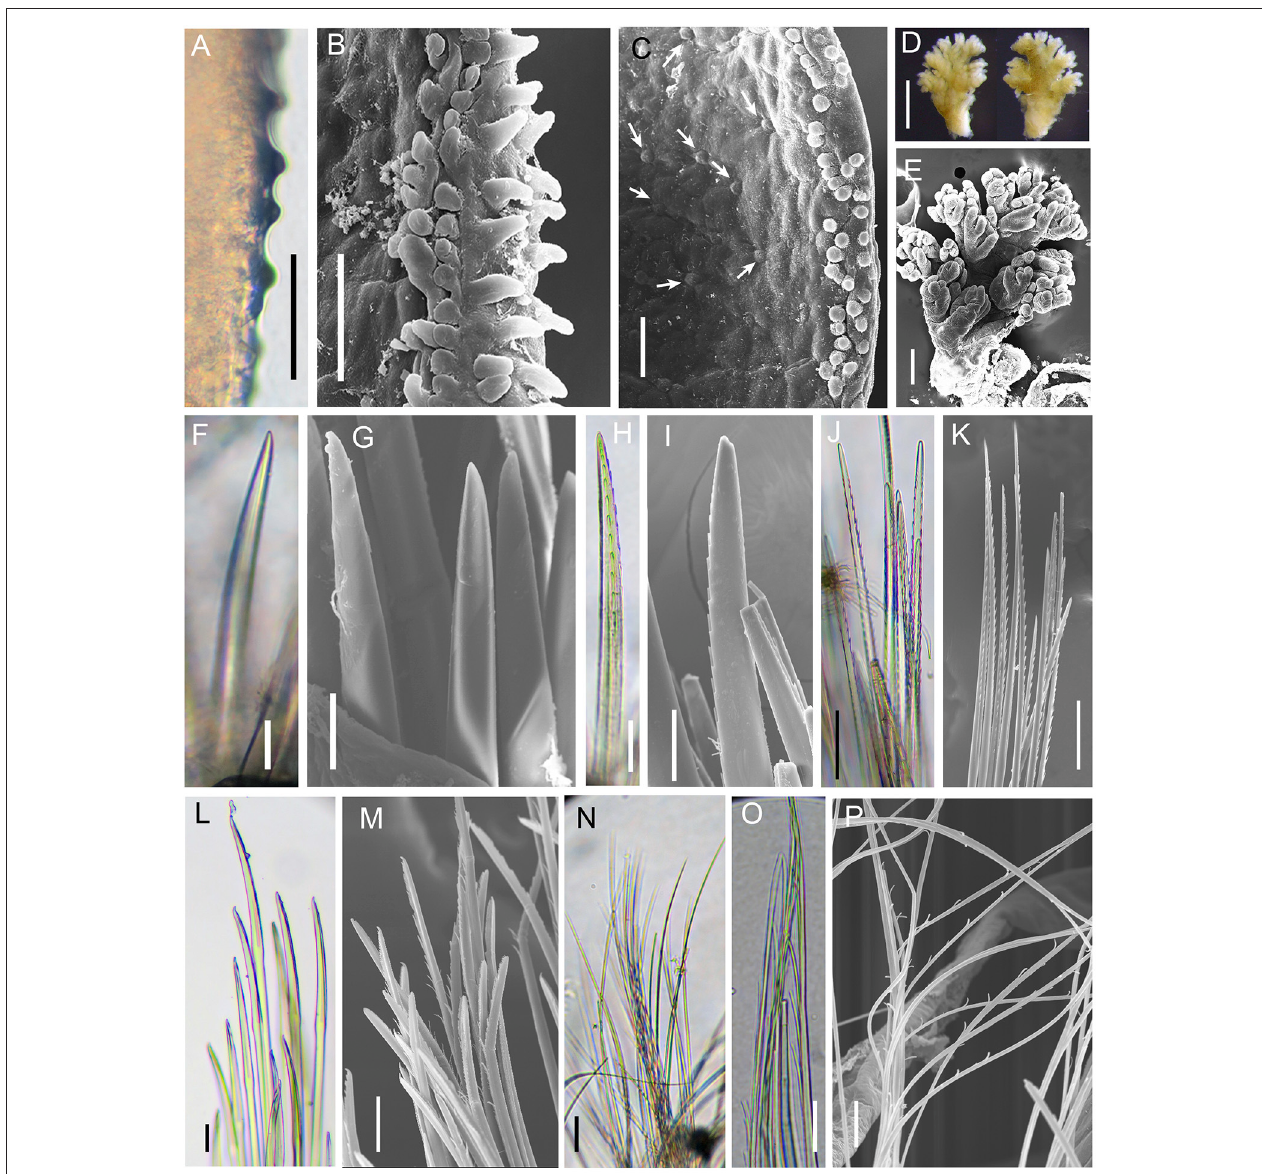
FIGURE 2 | Branchinotogluma elytropapillata sp. nov. Details of scale and chaetae. (A–M) are from Paratype 2. (N–P) are from Paratype 5. (A–C) globular and microtubular papillae on the margin of elytron. Arrows in (C) show the tiny globular papillae. (D–L) are from segment 11. (D,E) shape of branchiae, (F–I) notochaetae. (J,K) upper neurochaetae. (L,M) lower neurochaetae. (N) capillary neurochaetae from posterior end. (O,P) special chaetae from last parapodia. Scale bar: (A,B,C,F,G,L,M,N,O) 40 µ m; (D) 500 µ m; (H,I) 20 µ m; (E,J,K) 100 µ m; (H) 60 µ m; (P) 10 µ